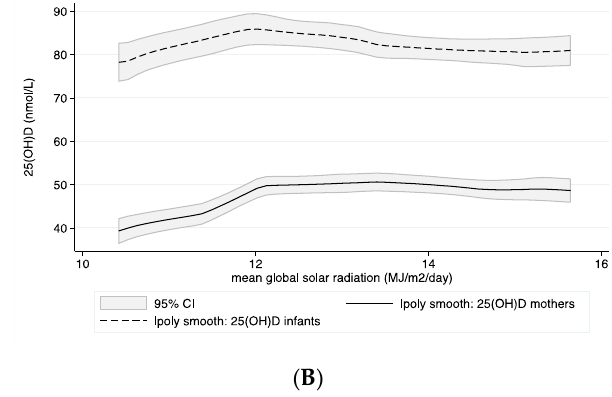
Figure 2. Infants and mothers 25(OH)D, and variability with month of the year ( A ) and global solar radiation ( B ). ( A ) 25(OH)D concentration by month 1–12 of the year (January–December) for infants (upper line) and mothers (lower line); ( B ) 25(OH)D concentration by global solar radiation for infants (upper line) and mothers (lower line).